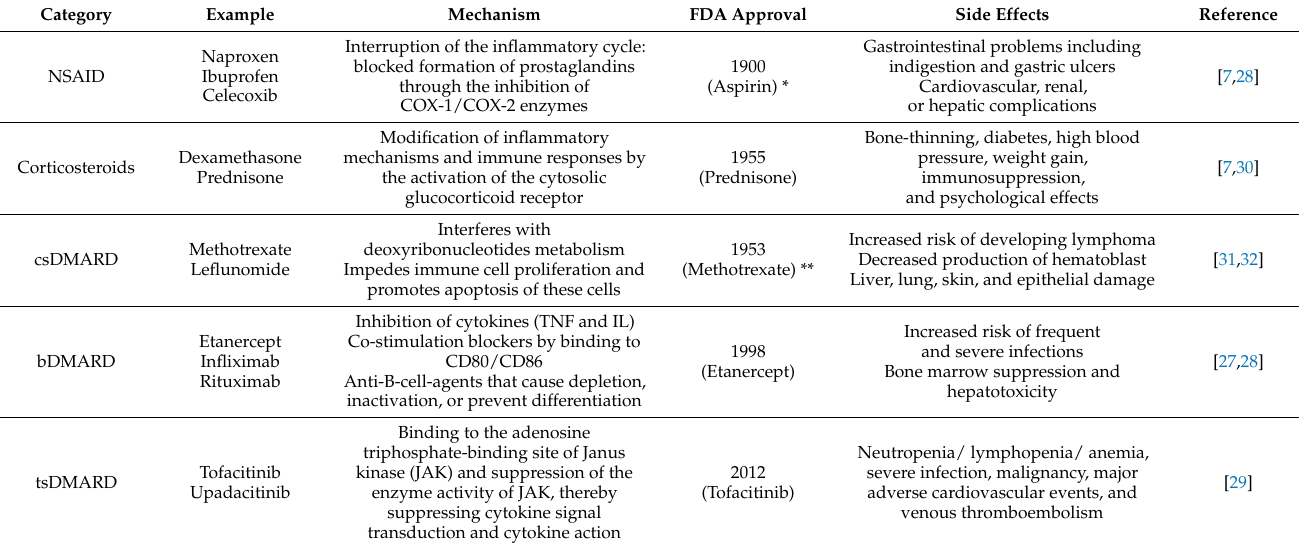
Table 1. Overview of available treatments for